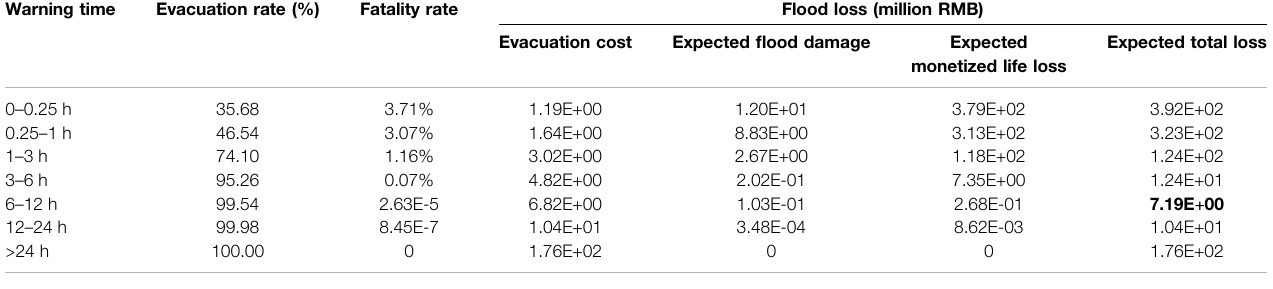
TABLE 6 | Flood losses in Scenario 1 in Beichuan County with different W t . Warning time